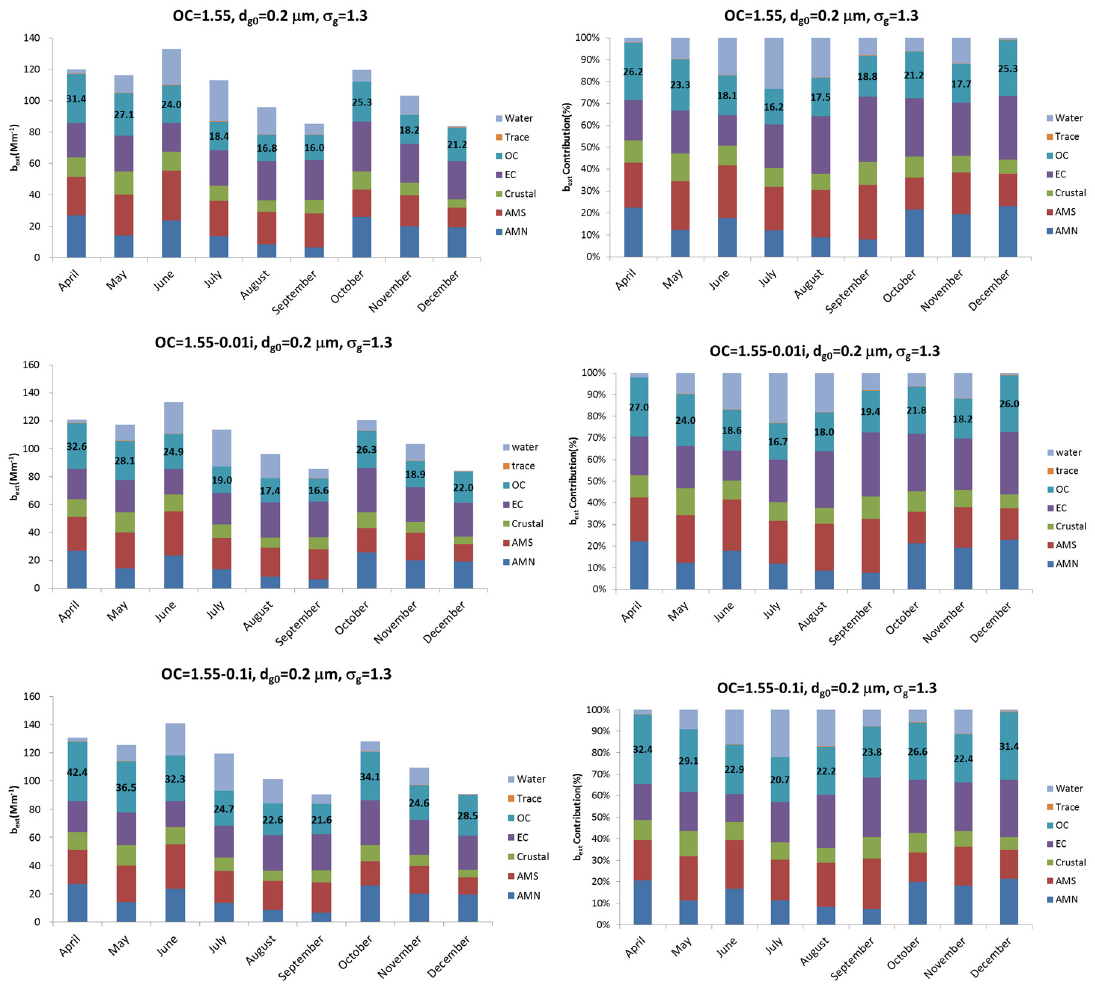
Figure 4. Comparison of the monthly averaged extinction coefficient and extinction coefficient contribution, between different refractive indices of the organic carbon ( λ = 550 nm).